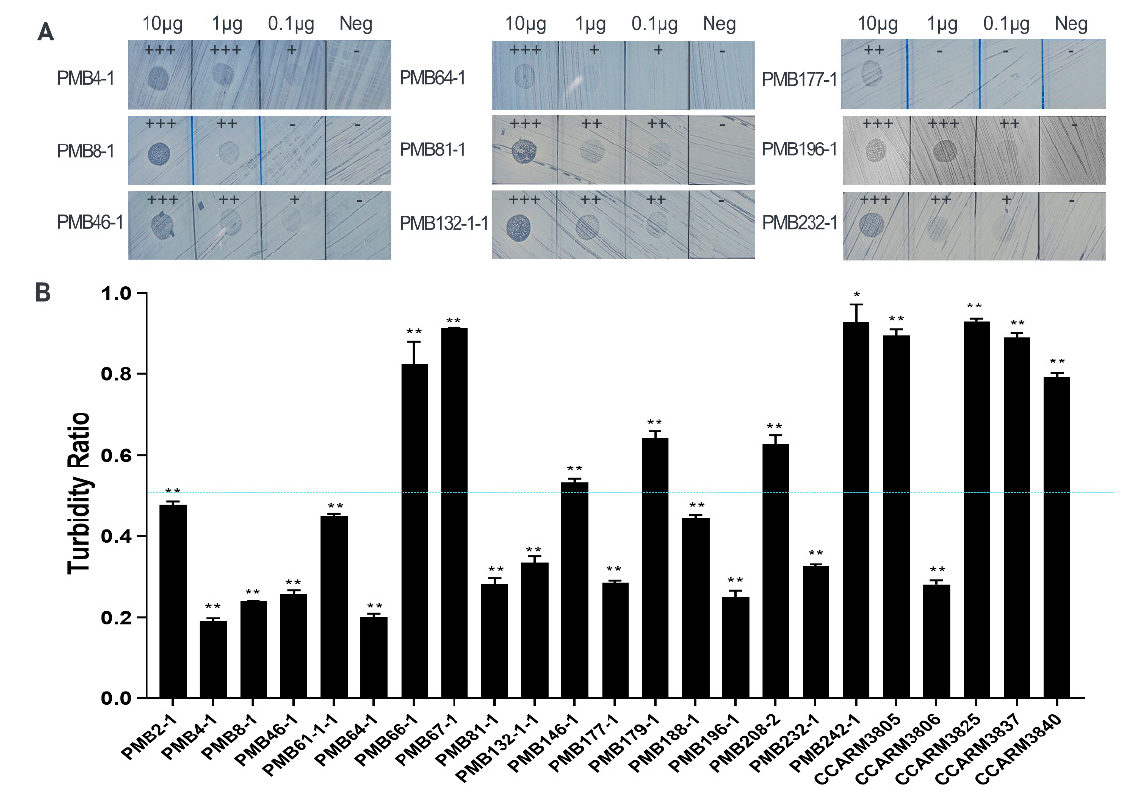
Figure 5. Comparison of antibacterial activities of E. coli -expressed and highly puri fi ed ALS2 using plate lysis and turbidity reduction tests. ( A ) Plate lysis test of puri fi ed ALS2. Treatment with the protein resulted in formation of a clear zone against various PMB strains (isolated from bovine) at concentrations of 10/1/0.1 µg/µL for the negative control (Neg), only protein puri fi cation bu ff er was used. +++, completely clear lysis; ++, incompletely clear lysis; +, distinguishable lysis in comparison with negative; -, no lysis. ( B ) After 10 min incubation of bacteria and highly purified ALS2, the turbidity ratio (TR) for each strain was determined by calculating the OD 600 value ratio of ALS2-treated to untreated samples. Single experiment was performed in triplicate samples and the mean ± standard deviation of TR values is presented. The significance of the ALS2 treated and untreated groups was analyzed by t -test. ( n = 3, ** p < 0.01, * p < 0.05). A total of 23 strains of S. aureus from bovine mastitis (18 PMB strains) and human infection (5 CCARM strains) were compared. The broken line represents the reference TR (0.5).